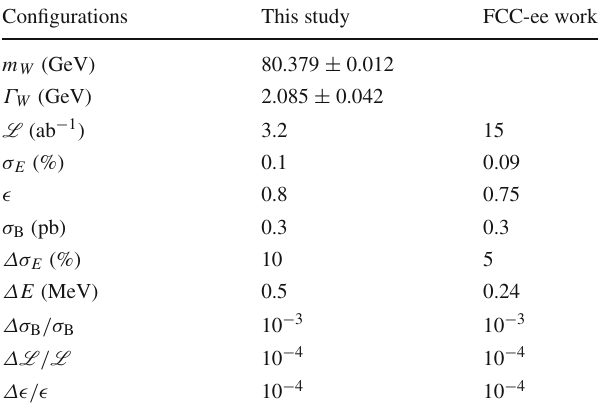
Table 1 The configurations of the data-taking assumed in this paper. Shown in the table are the world average values of the mass and width of the W boson [15]; the total integrated luminosity and its relative uncertainty, L and Δ L ; the means and uncertainties of beam energy and its spread, E , E BS , Δ E , and Δ E BS ; the relative uncertainties of the background, and detection efficiency, Δσ B , and Δ(cid:14) . The second column is used in this study and the third one in FCC-ee’s paper